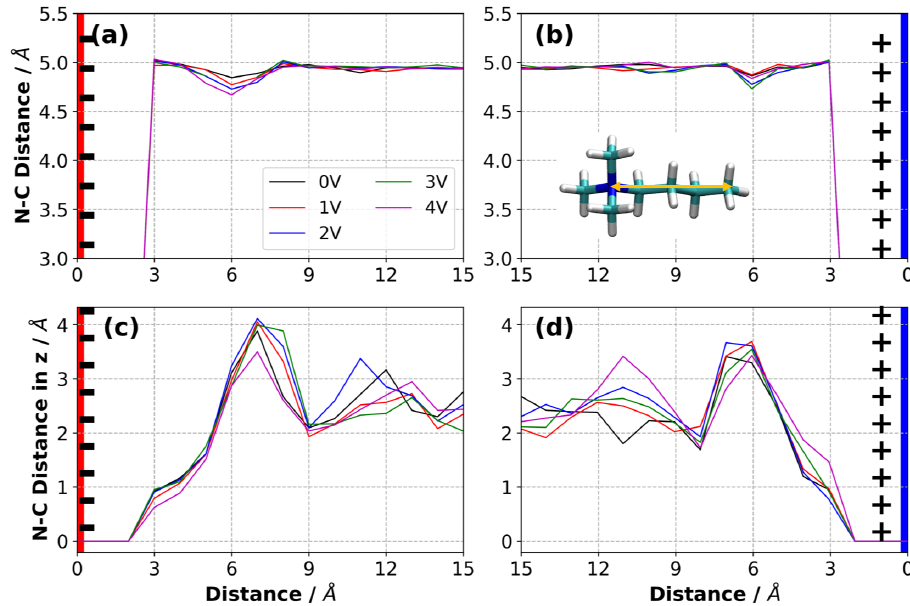
Figure 15. Distribution of the nitrogen-to-distal carbon distance in [N 4,1,1,1 ] + ions calculated in all three dimensions on the ( a ) negative electrode, ( b ) positive electrode, and in the normal direction to the electrode surface (the z-direction) on the ( c ) negative electrode and ( d ) positive electrode for each ∆Ψ at 294 K (averaged over three independently generated samples). The yellow arrow represents the distance between nitrogen and carbon